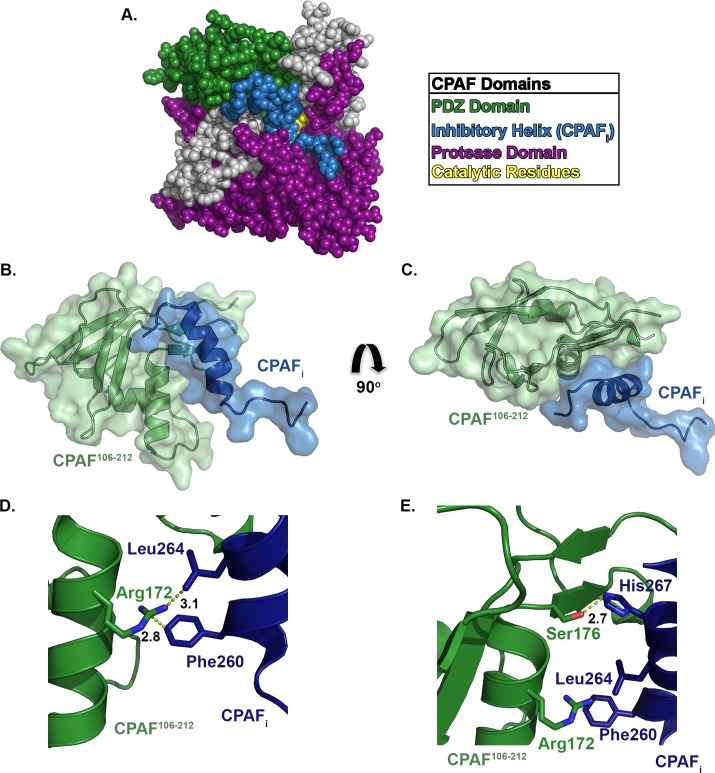
The CPAF Inhibitory Helix Makes Substantial Contact with the PDZ Domain in the Inactive Zymogen.(A) The domain organization of the CPAF zymogen (PDB ID: 3DPN) [28] shows that the inhibitory helix (CPAFi) resides in the active site groove and contacts both the protease and PDZ domains. (B) CPAF106-212 (green) is shown making multiple contacts with CPAFi (blue). (C) Rotation of the zymogen structure allows for visualization of the contact between the PDZ domain and CPAFi. (D) PDZ domain residue Arg172 makes cation-π and van der Waals interactions with CPAFi residues Phe260 and Leu264 respectively. (E) PDZ residue Ser176 forms hydrogen-bonding interactions with CPAFi residue His267.